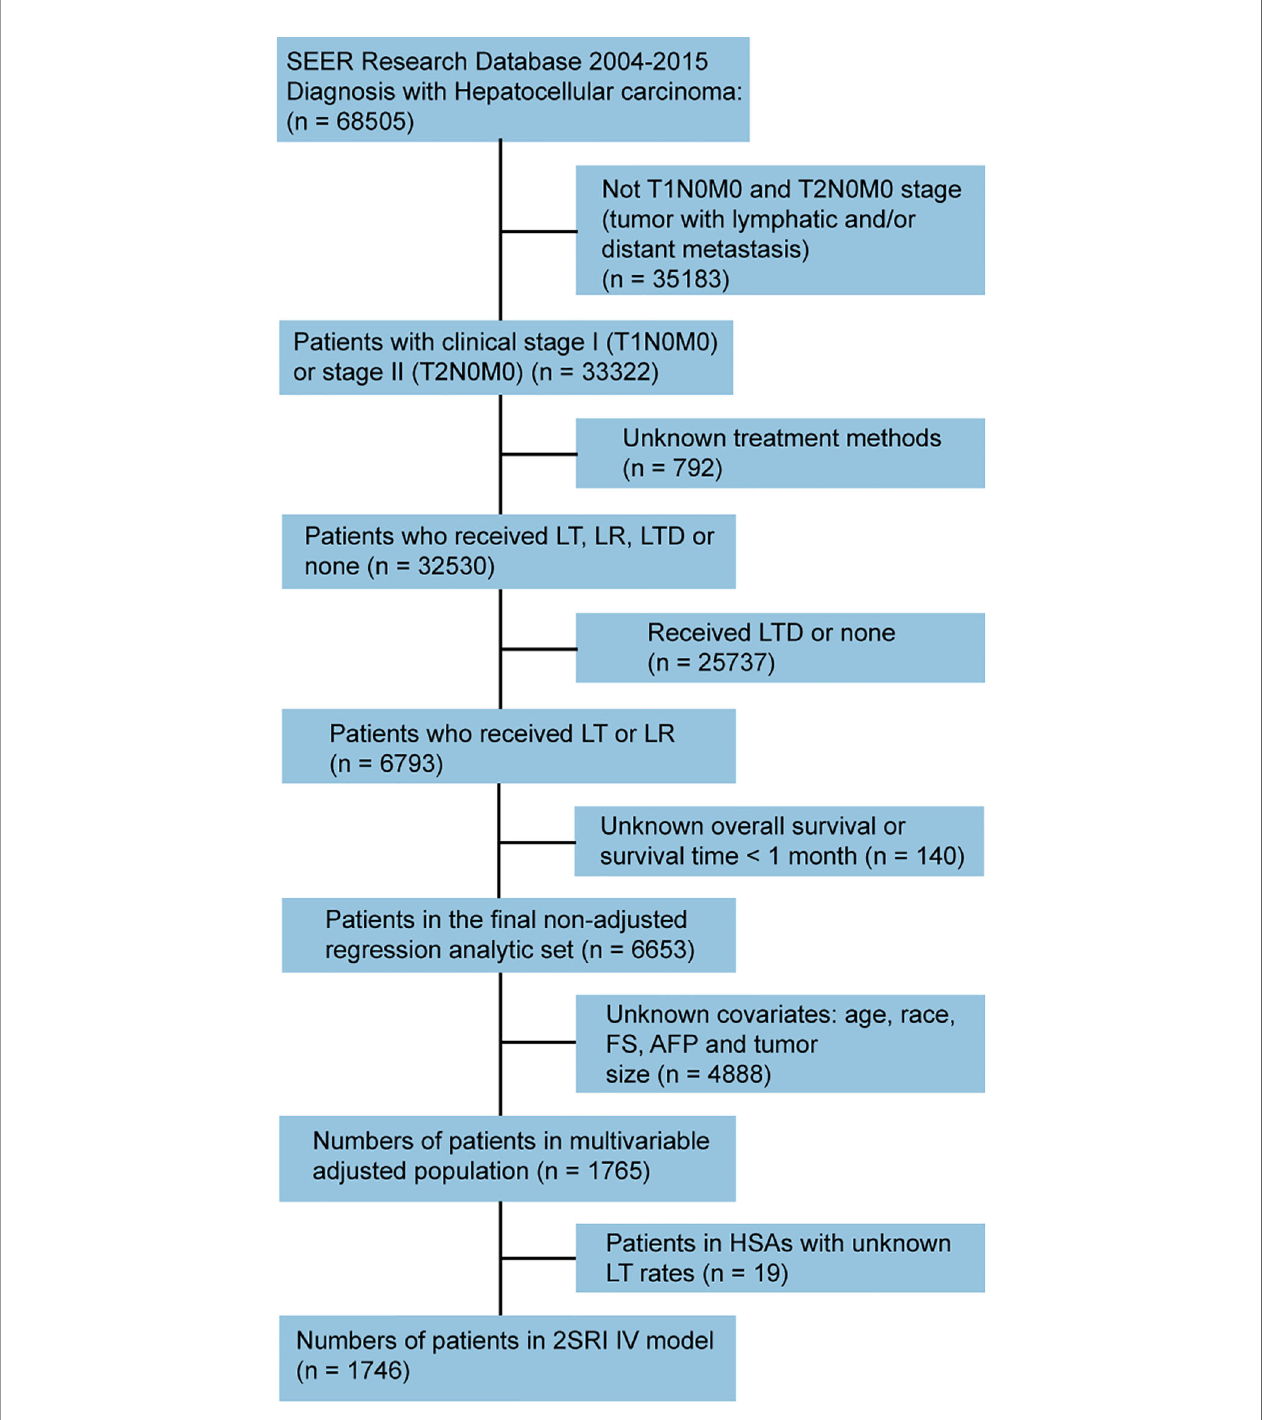
FIGURE 1 | Flowchart showing selection process of cases included in this study. SEER, Surveillance, Epidemiology, and End Results; LT, liver transplantation; LR, liver resection; LTD, local tumor destruction; FS, fi brosis score; AFP, alpha-fetoprotein; HAS, Health Service Area; 2SRI, two-stage residual inclusion; IV, instrumental